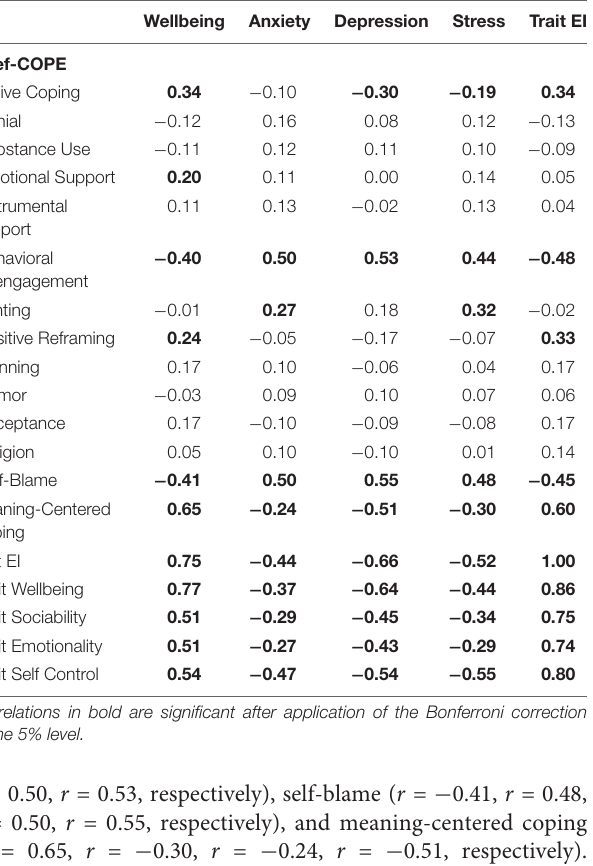
TABLE 3 | Correlations among study variables.